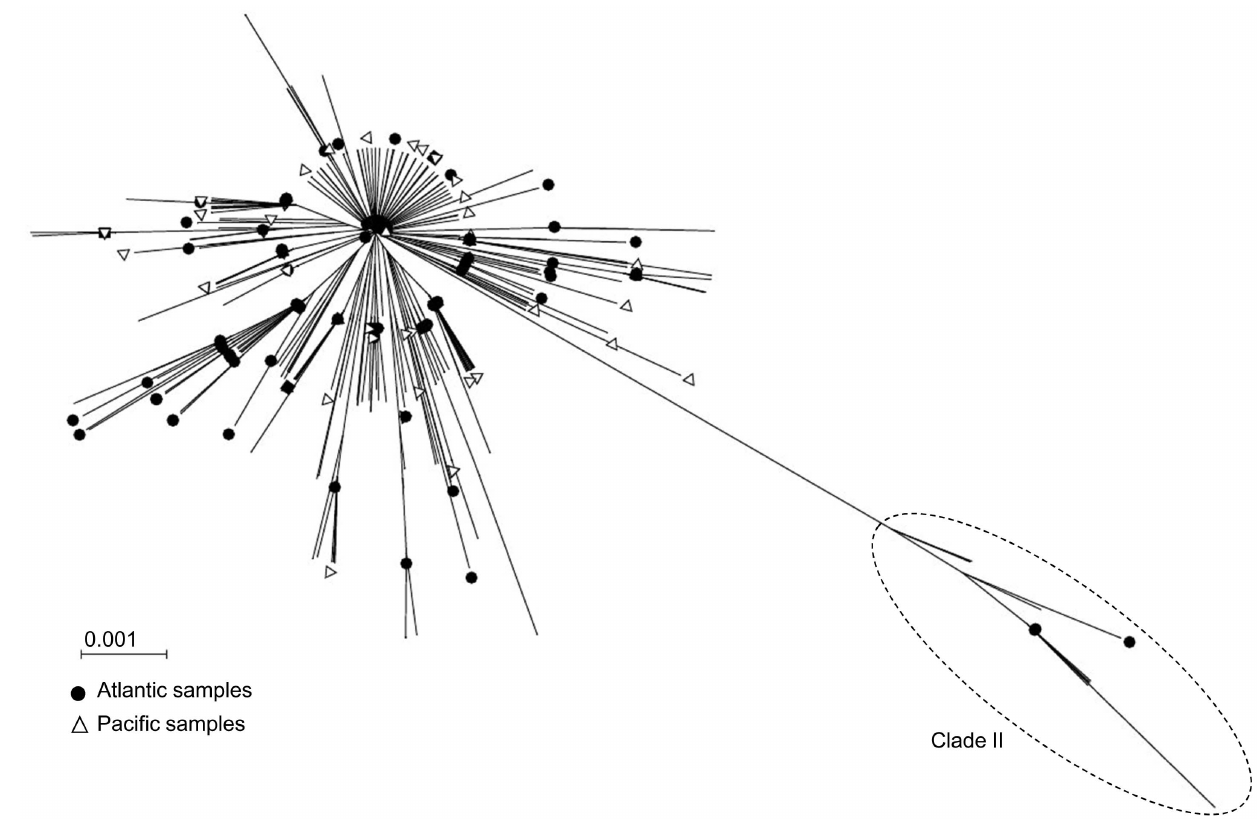
Figure 2. Unrooted neighbor-joining tree showing the relationship between the ND2 sequences (n=2001). White triangles are samples from the Pacific Ocean (5.5% of the samples), black circles from Atlantic Ocean (8% of the samples) and branches without symbol are from Indian Ocean (86.5% of the samples). Clade I and clade II names refer to the same nomenclature proposed in Alvarado-Bremer et al. , (2005a).